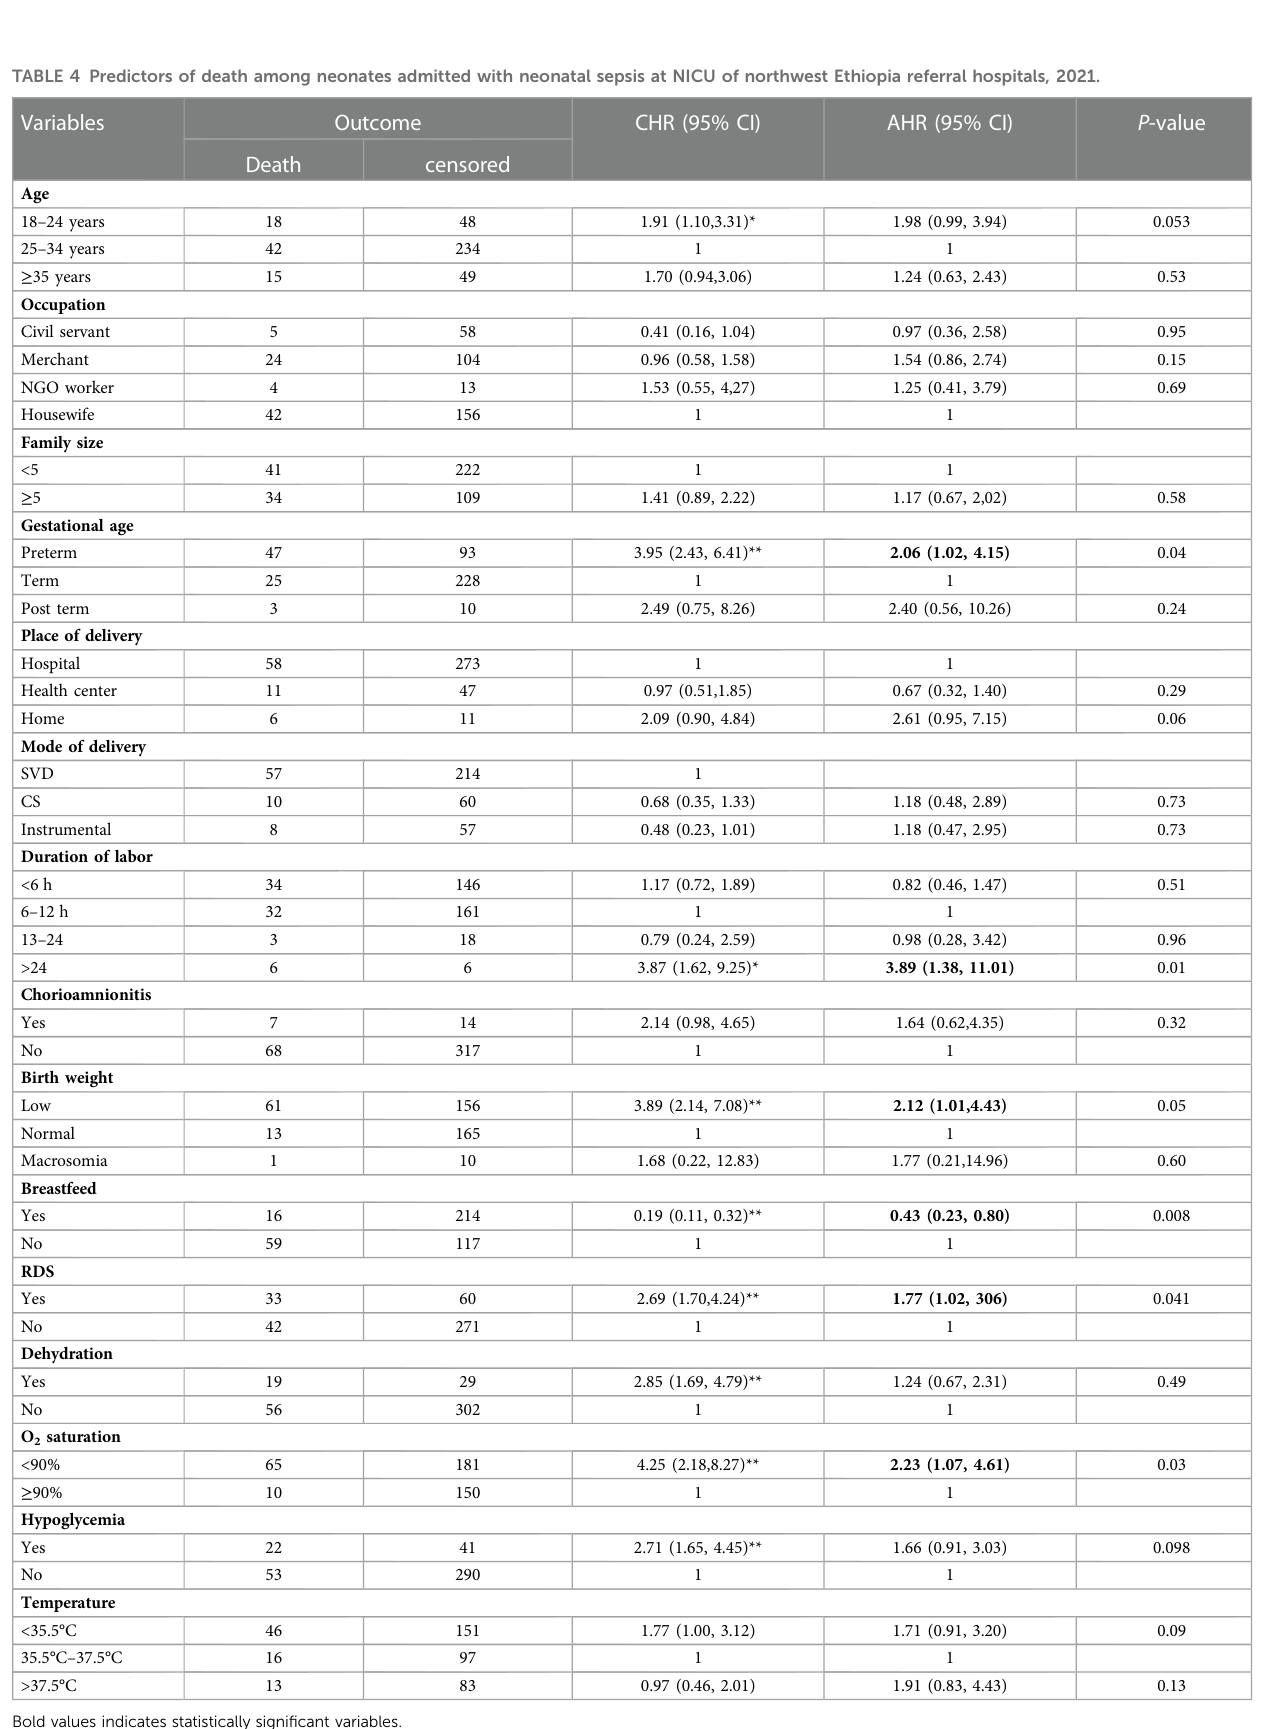
Bold values indicates statistically signi fi cant variables. *Statistically signi fi cant at P-value 0.05. **Statistically signi fi cant at P-value